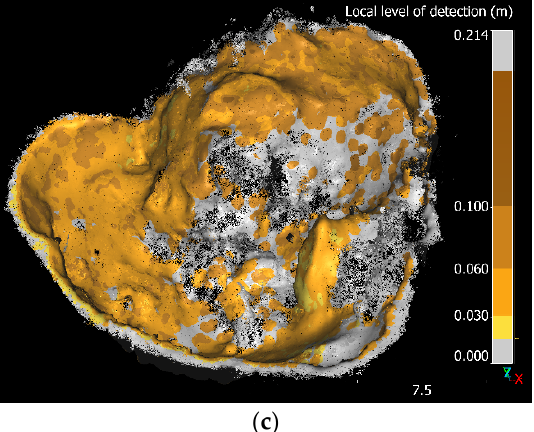
Figure A3. ( a ) 2017 Terr UAV, ( b ) 2018 Terr UAV and ( c ) 2019 Terr UAV. ( a – c ): Local level of detection for the comparison of point clouds resulting from using terrestrial or aerial imagery. Gray colors in the point clouds reflect areas with no information point precision estimates available in any of the point clouds of the comparison pair. In the color scale the gray areas show that there are no values available, therefore they are indicating the range of the local levels of detection of the respective comparison pair.